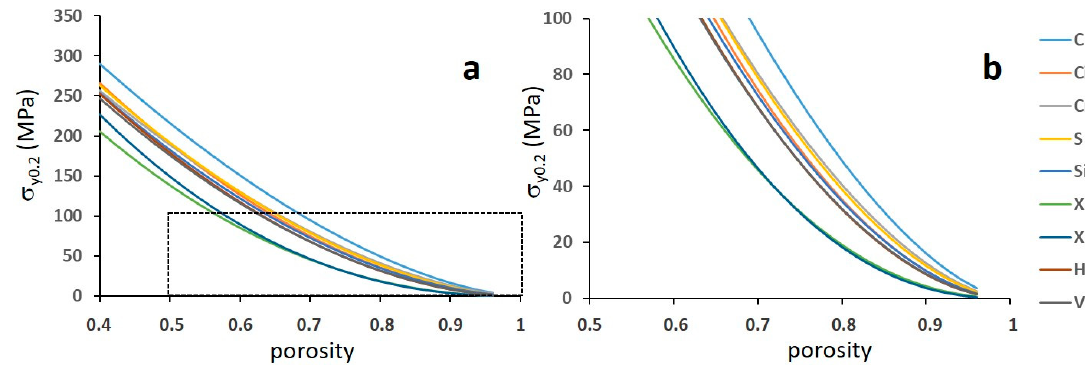
Figure 17. Effect of porosity on the yield strength according to the Gibson–Ashby model. The letters refer to structures. The graph ( b ) is an enlarged inset of the dashed area in the graph ( a ).